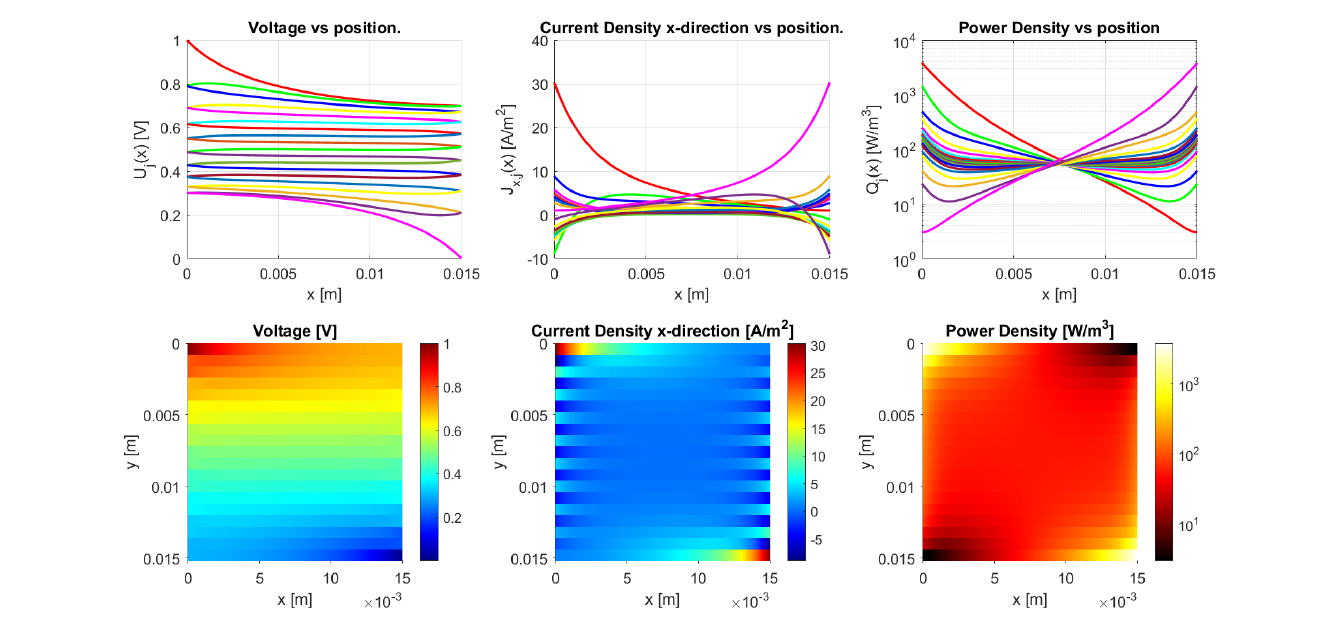
Figure 20. The model results for a meandering sample with the parameters from Table 2 and an inter-traxel resistance of σ = 2 × 10 − 4 Ω m 2 . This gives an anisotropy ratio of 0.918, showing bulk conduction.